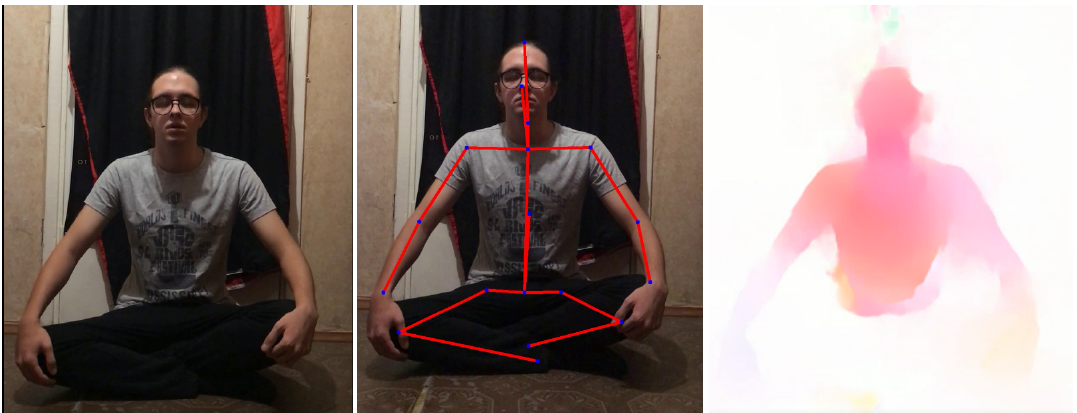
Figure 19. Human movement estimation based on skeleton detection.